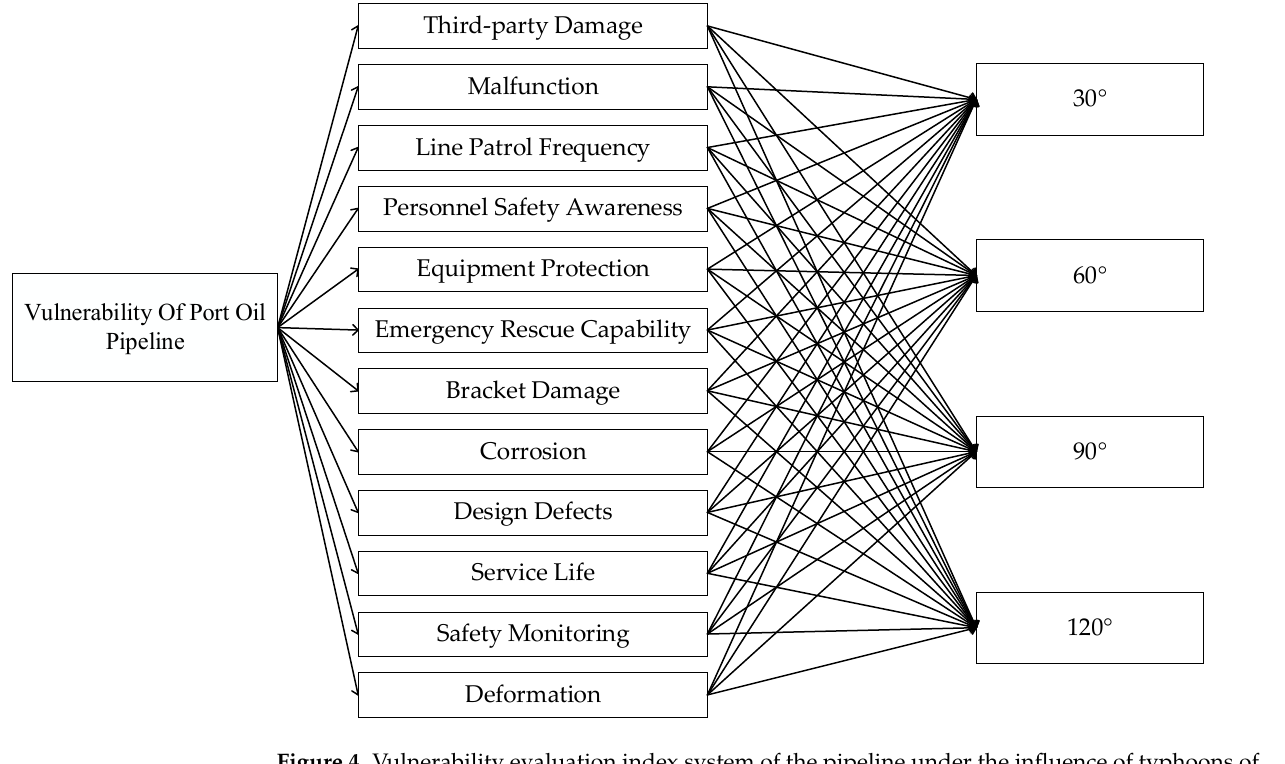
Figure 4. Vulnerability evaluation index system of the pipeline under the influence of typhoons of different wind attack angle.